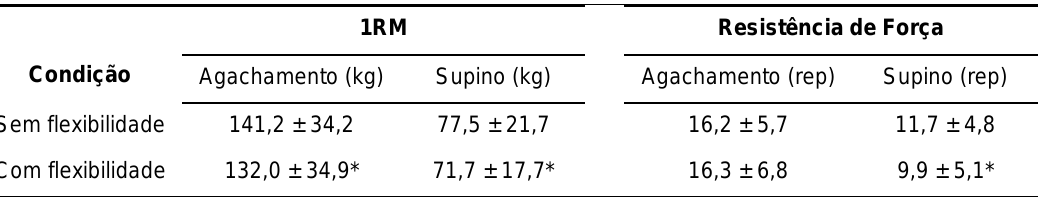
Tabela 1. Desempenho de força máxima (kg) e de resistência de força (repetições) nos exercícios agachamento e supino com e sem exercícios de